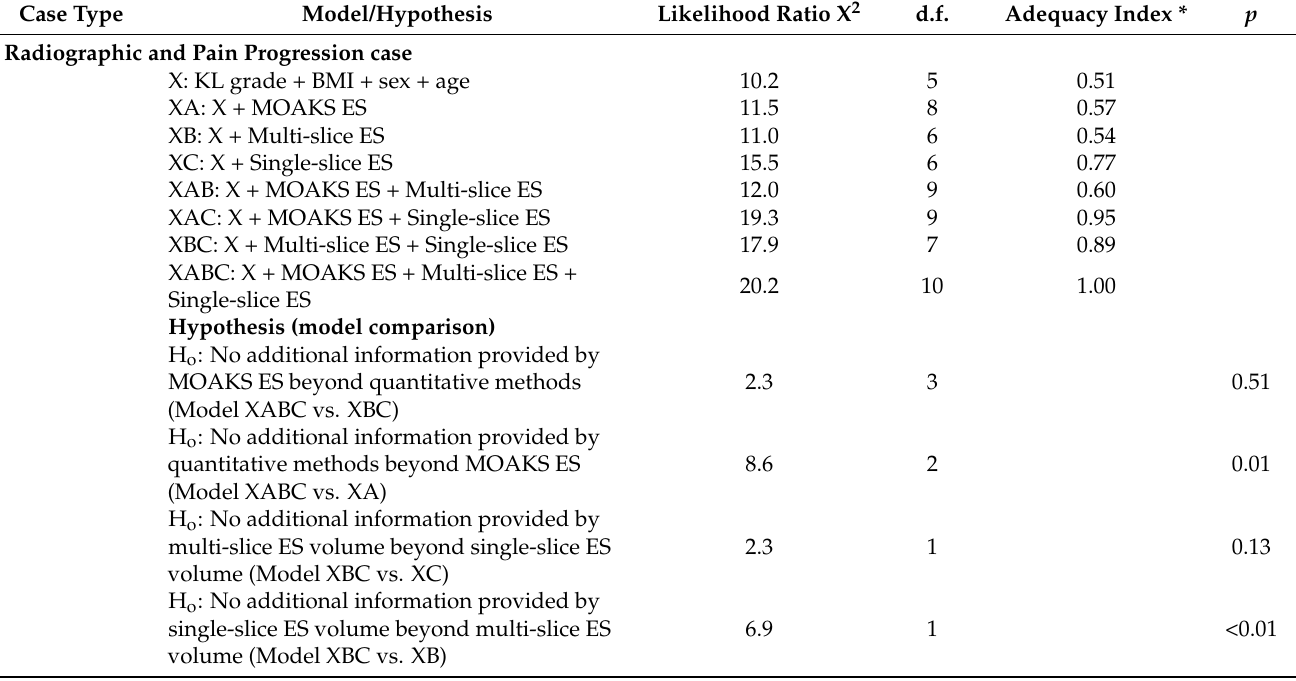
Figure 5. Single-slice effusion-synovitis (ES) volume vs. MOAKS (MRI Osteoarthritis Knee Score) ES. Table 3. Contributions of MOAKS ES, Multi-slice ES volume and Single-slice ES volume to FNIH case–control